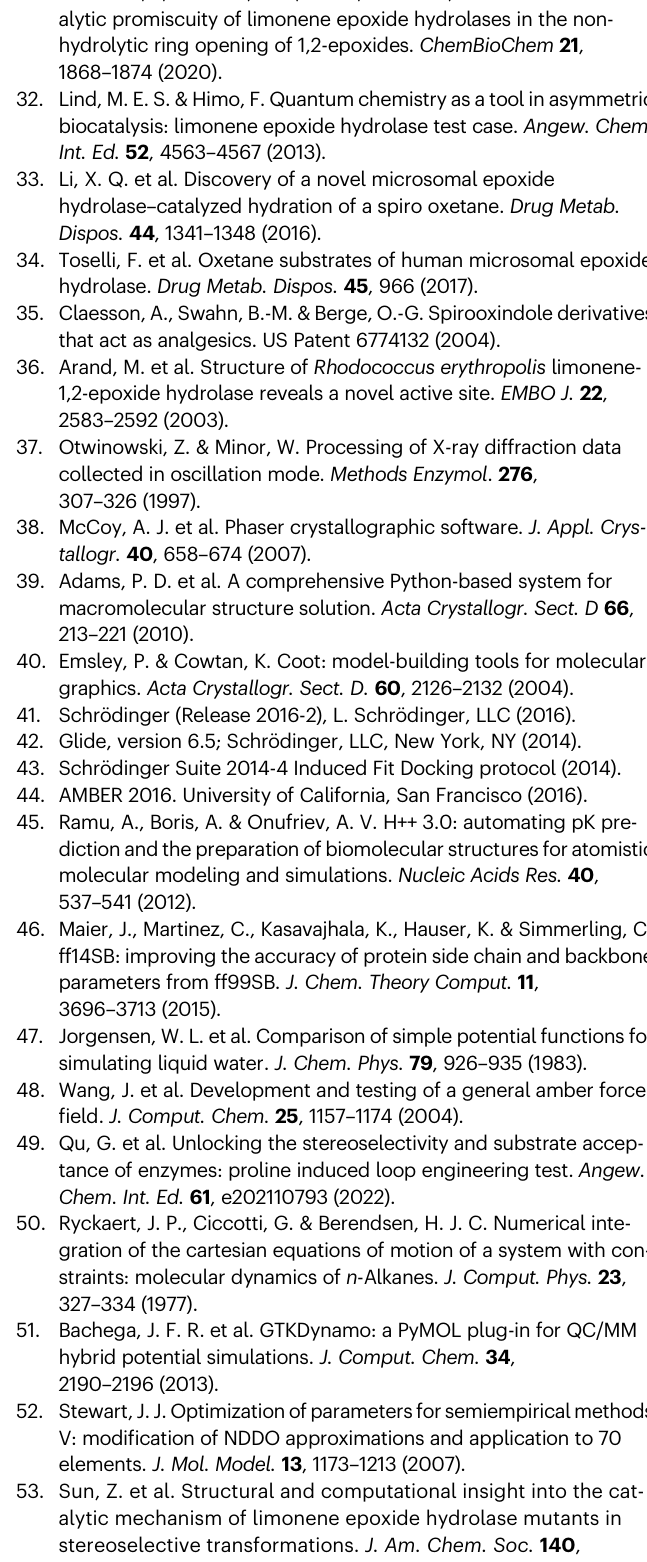
ff14SB: improving the accuracy of protein side chain and